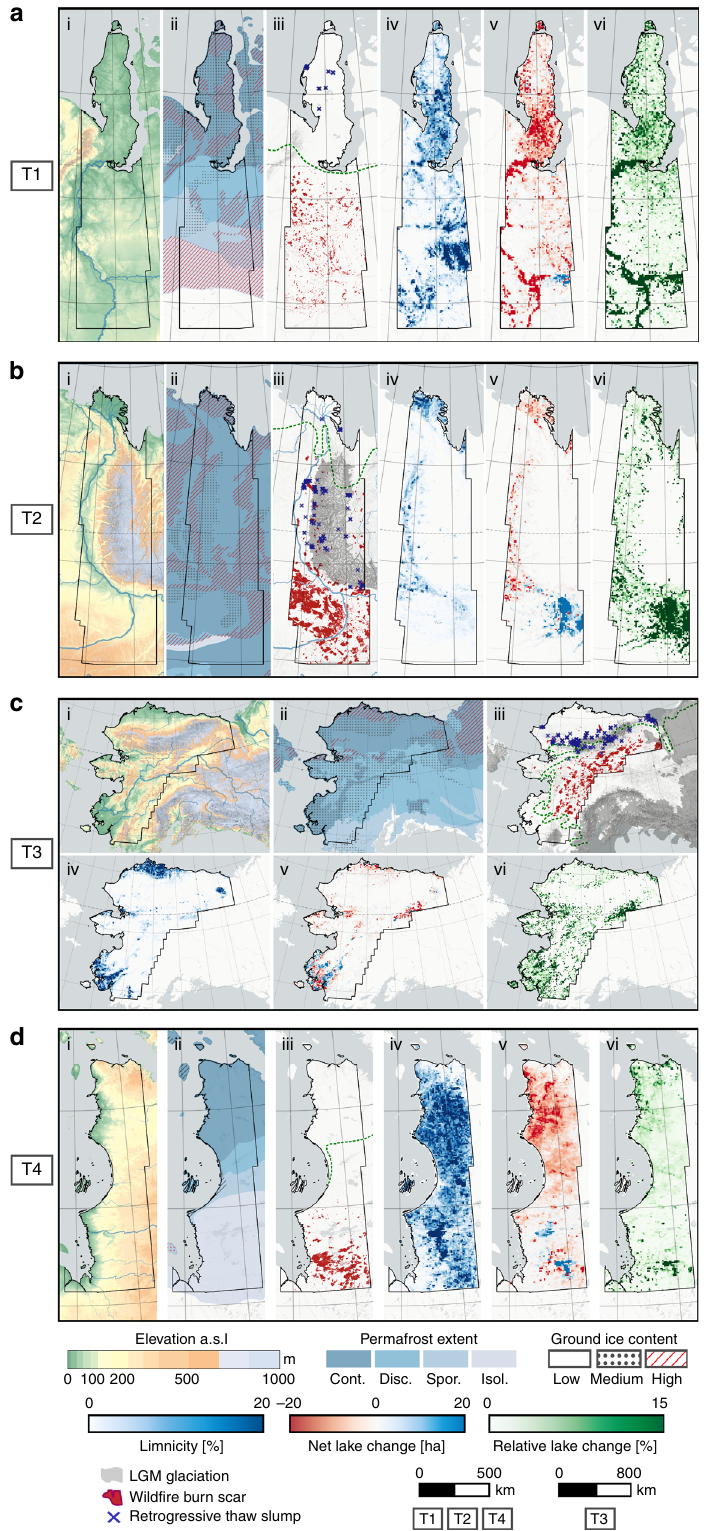
Fig. 3 Environmental conditions and results of permafrost regions disturbance detection. Lake statistics and permafrost conditions in the four continental- scale, latitudinal transects: a T1 Western Siberia, b T2 Eastern Siberia, c T3 Alaska, and d T4 Eastern Canada. (i) Surface elevation of study sites, (ii) permafrost conditions with permafrost extent in shades of blue and ice content based on IPA Permafrost map 20 , (iii) Wild fi re burn scars, retrogressive thaw slumps, LGM glaciation extent 63 and treeline 20 . LGM glacial coverage omitted in T4 for visual purposes, (iv) Limnicity: Lake fraction of land surface per grid cell (7.5 ×7.5 km), (v) Net lake change: lake area change per grid cell (7.5 ×7.5 km), (vi) Relative lake change: fraction of changing lake area to stable lake